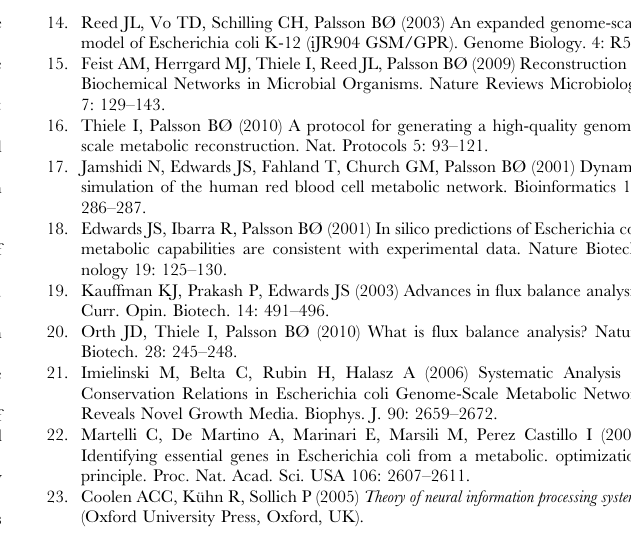
Table S2 Reactions (abbreviation, enzyme name,